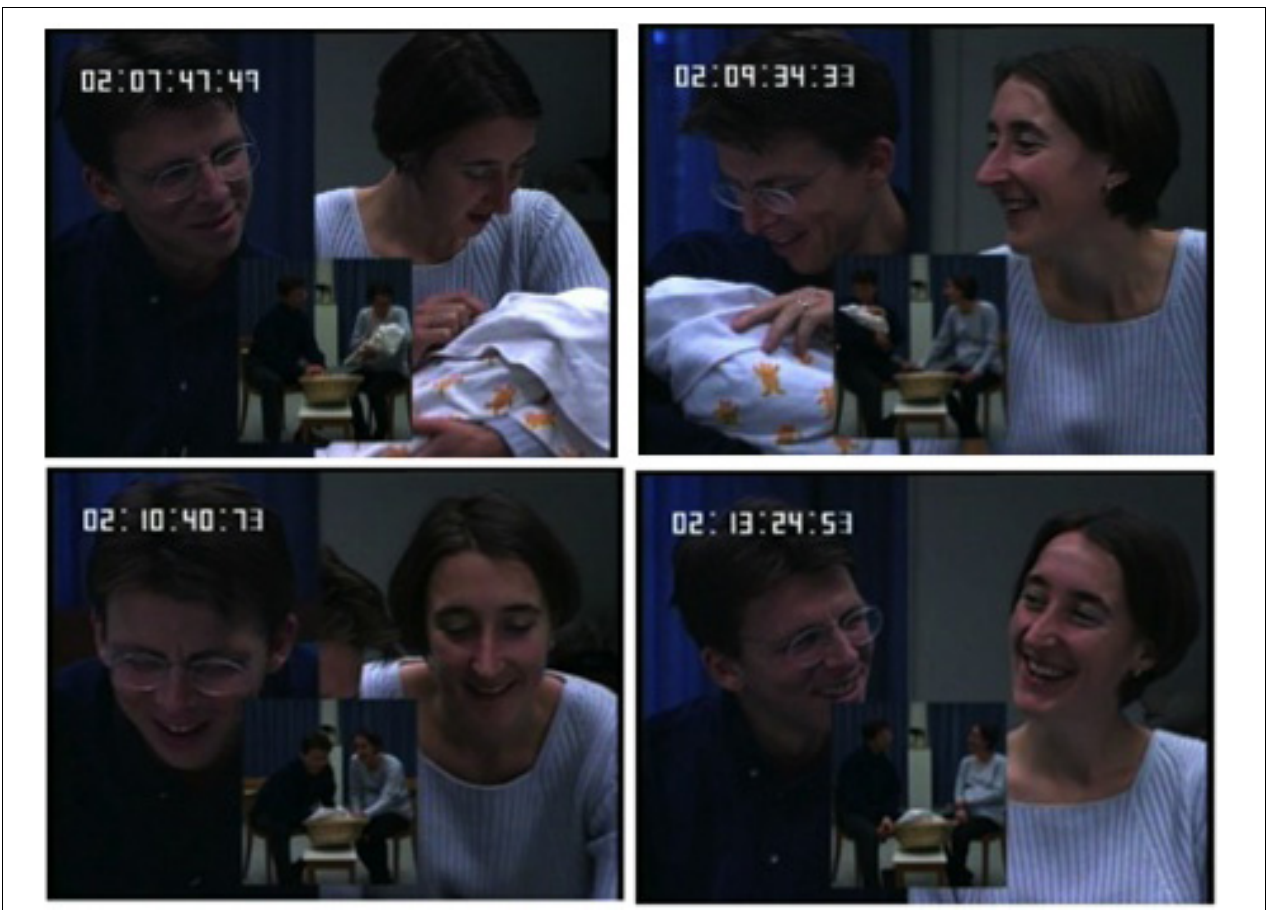
FIGURE 1 | The four parts of the Prenatal Lausanne Trilogue Play procedure. (Part 1) Mother plays with the “baby.” (Part 2) Father plays with the “baby.” (Part 3) Parents play with the “baby” together. (Part 4) Parents talk together while “baby” is